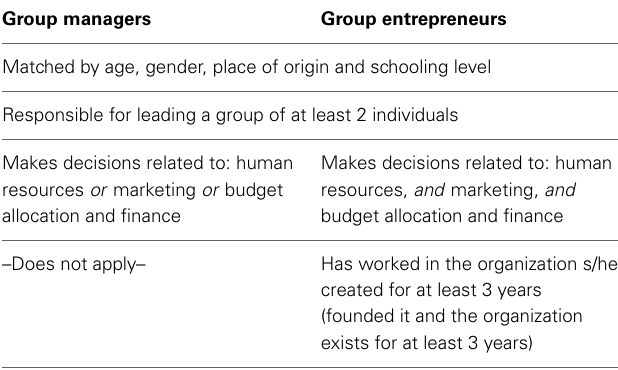
Table 1 | Participants’ selection criteria.